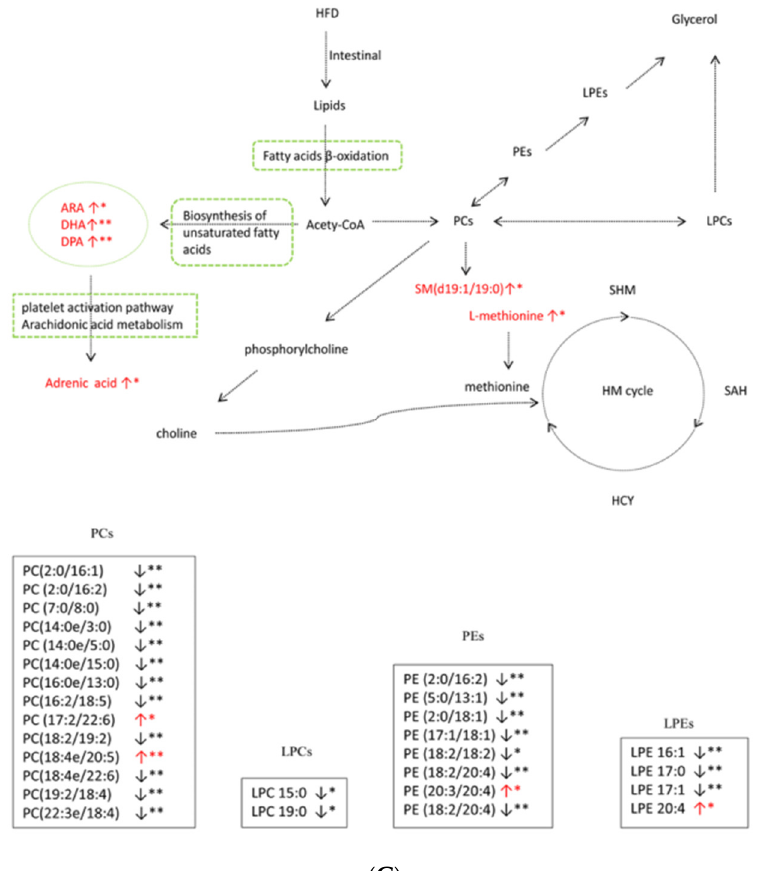
Figure 4. Metabolic pathway analysis. KEGG positive ( A ) and negative ( B ) pathway enrichment plots obtained with MetaboAnalyst. Metabolic pathways are represented by circles, circle size and color shade are based on pathway impact and p value (red being the most significant). ( C ) The network of metabolic pathways associated with the lipid cycle. Metabolite levels are shown in color: red represents increased levels, and black represents decreased or undetected levels. Trend and p value (HFD vs. SND): * p < 0.05; ** p < 0.01.